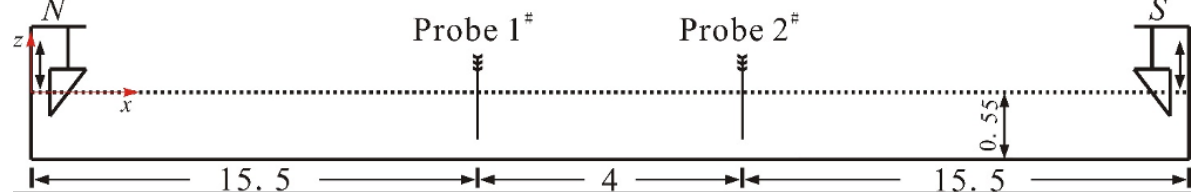
Figure 12. Diagram of the experimental setup, including probe #1 and probe #2. Note N denotes north end; S indicates south end. Unit: